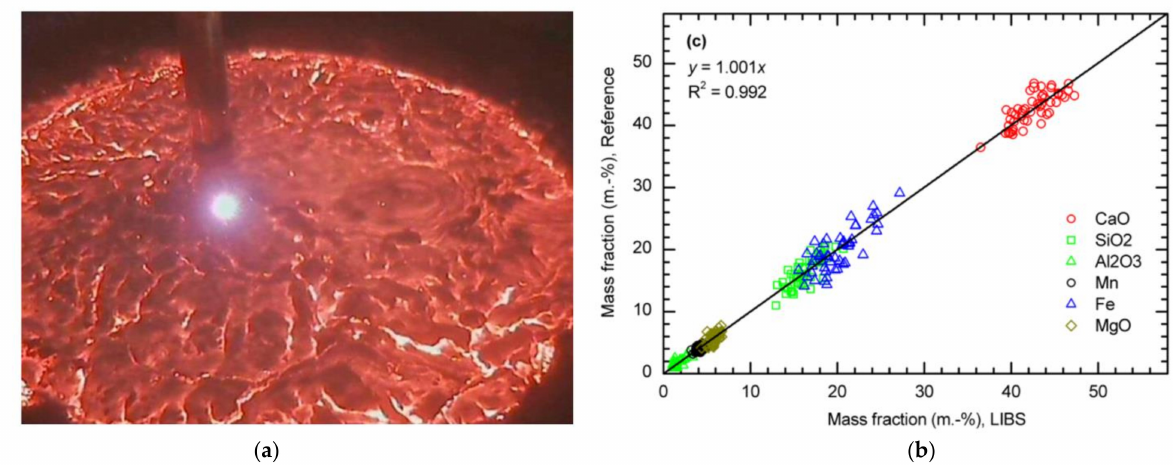
Figure 19. LIBS in-line measurement of liquid converter slag at voestalpine steel plant. ( a ) Photograph of the laser-induced plasma at the slag surface in the slag ladle. ( b ) Concentration of major oxides obtained by calibration-based analysis vs. reference concentration (dashed line: ideal match). Adapted from [373].